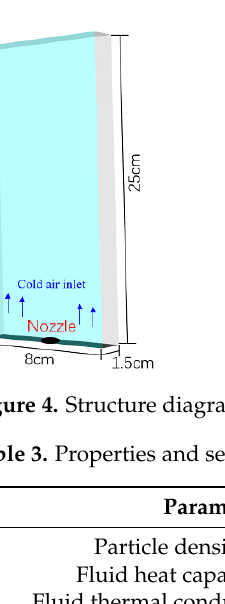
Table 3. Properties and settings used in the simulation.